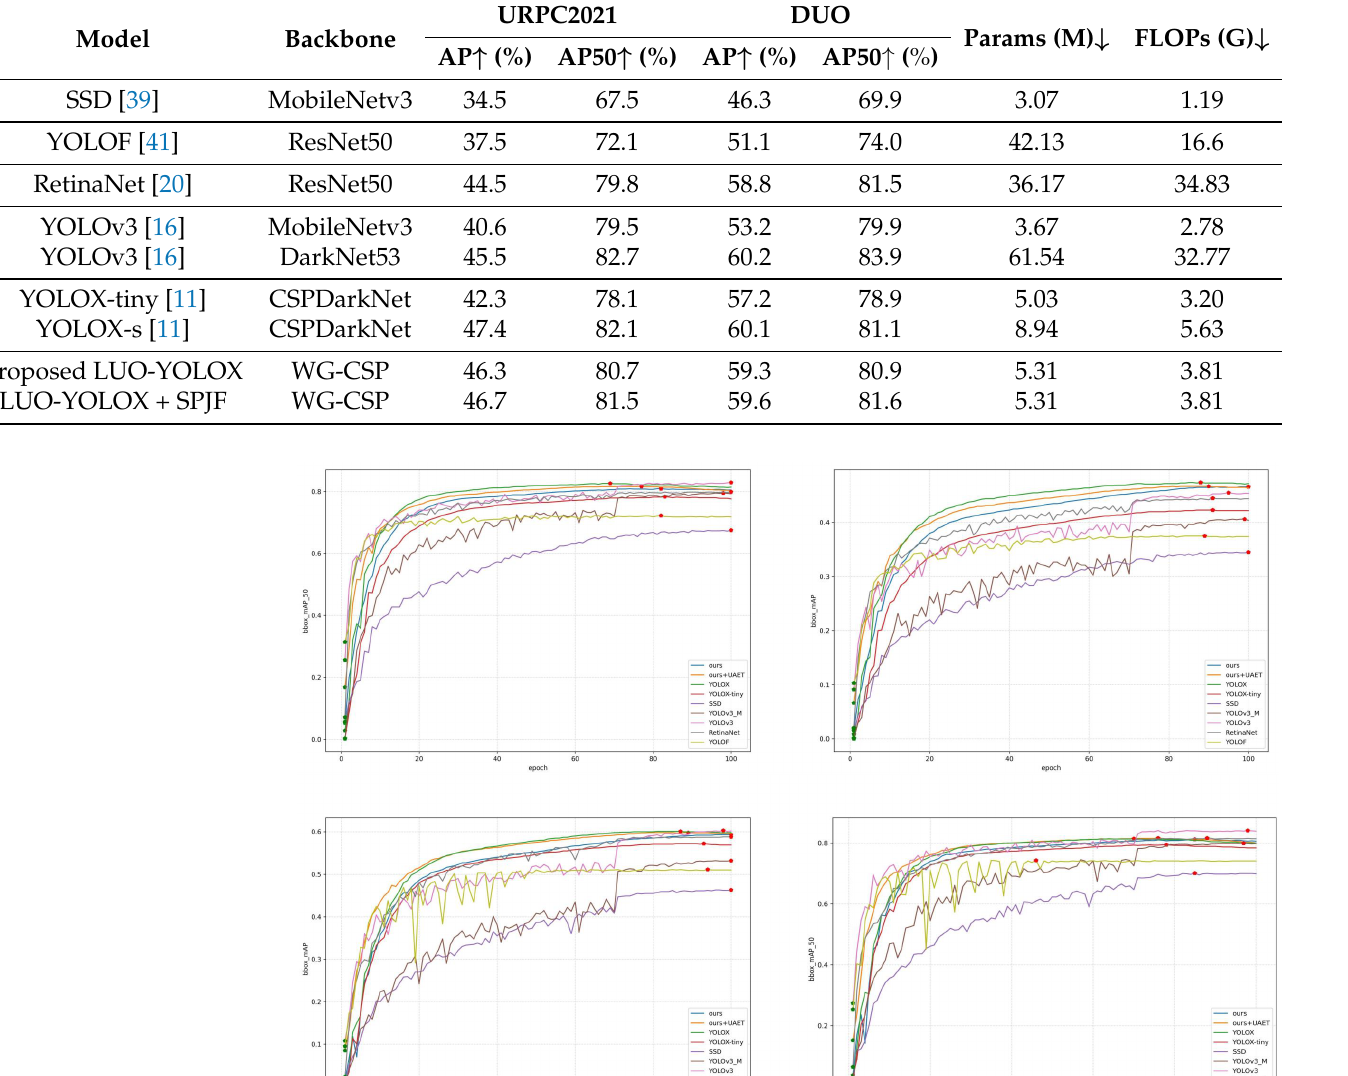
Table 2. The experimental results on the URPC2021 and DUO datasets.